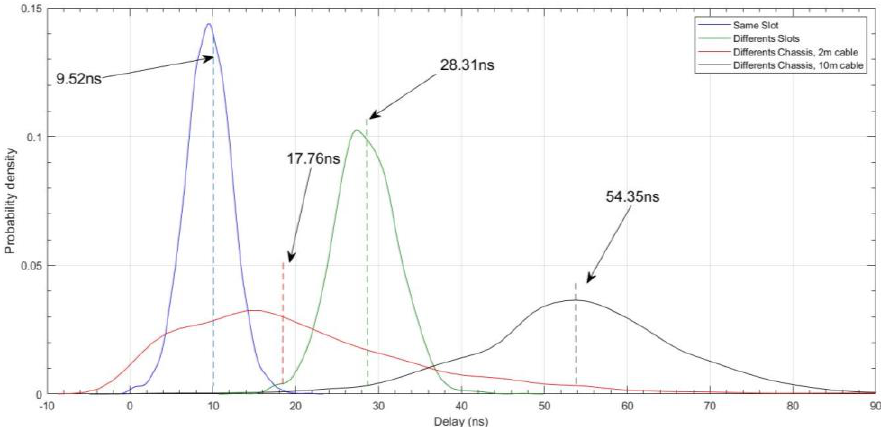
Figure 8. Probability density for Sigma-Delta converters.